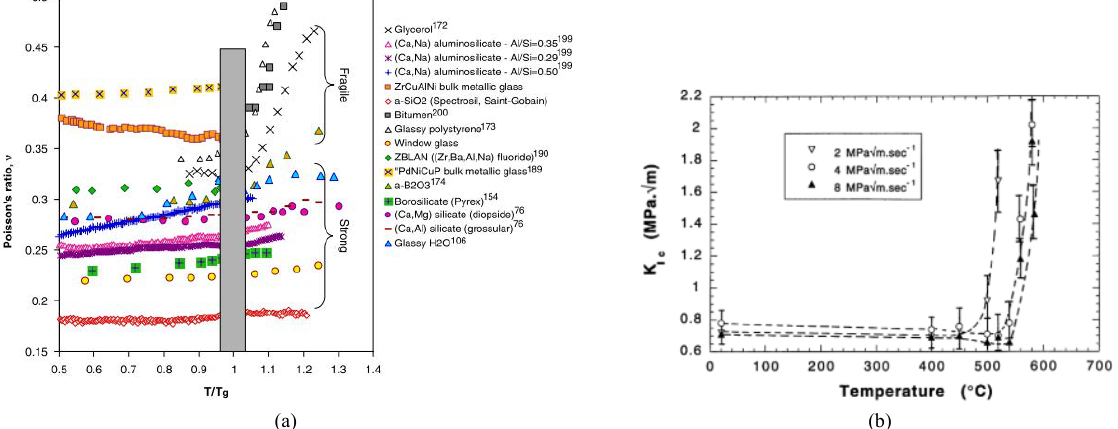
Fig. 3 Temperature dependence of (a) Poisson ratio of AN SLS glass and BS glass (Rouxel 2007) and (b) fracture toughness of AN SLS glass (Rouxel et al.